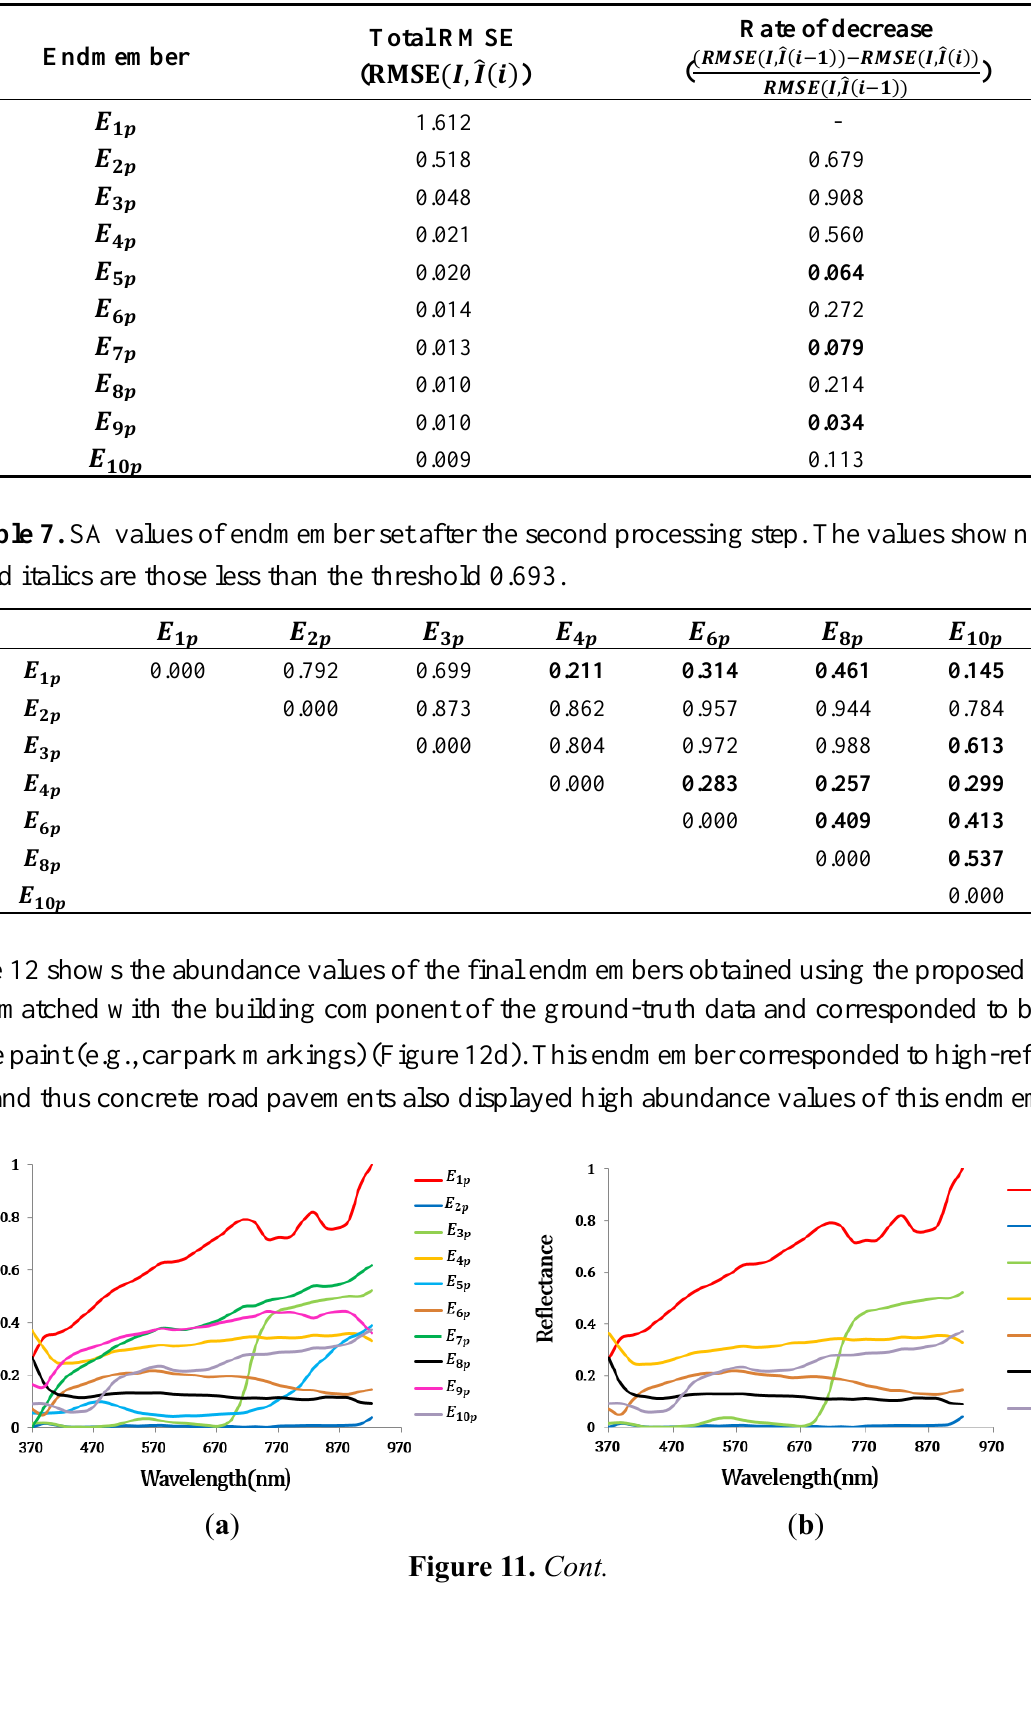
Table 6. RMSEs and rates of change of extracted endmembers. The values shown in bold italics are those of endmembers for which the rate of decrease is less than 0.1.